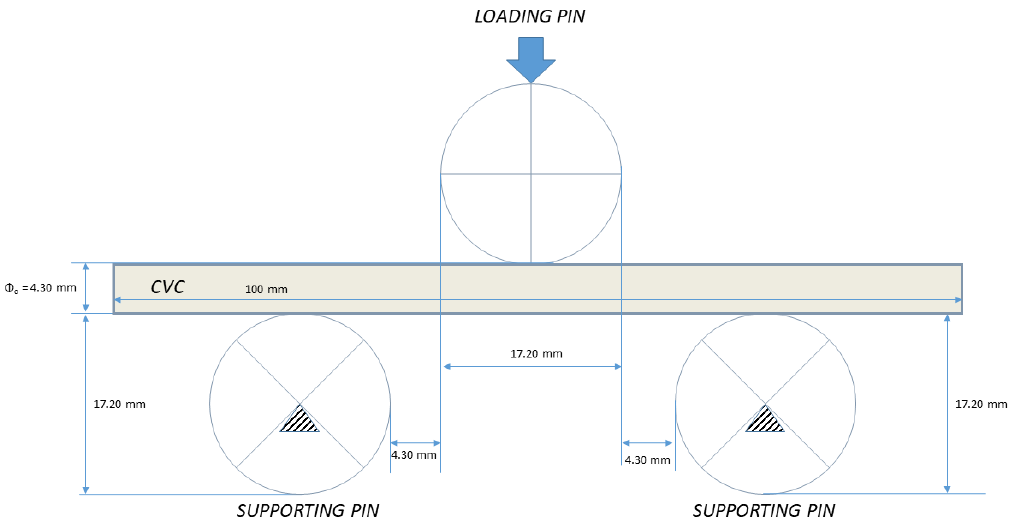
Figure 3. Side view of the three-point bending configuration: supporting pins are fixed, loading pin moves down on the plane.